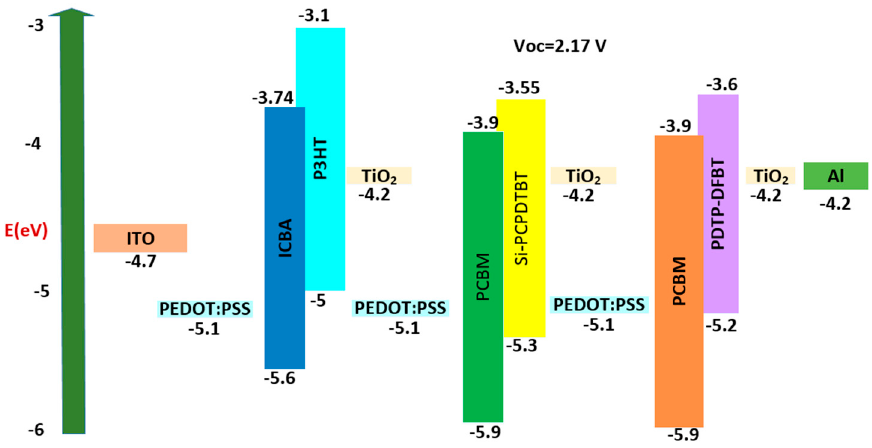
Figure 6. HOMO and LUMO band diagram for type 3 multi-junction PSC.